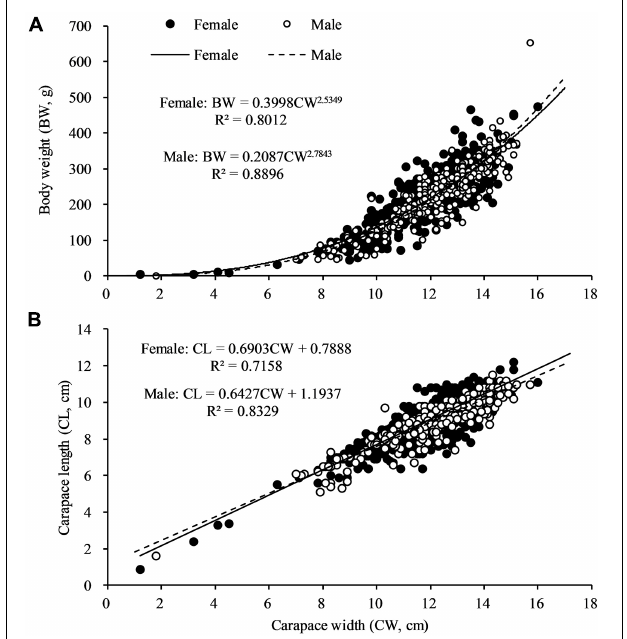
FIGURE 5 | (A) Body weight (BW) and carapace width (CW) relationship, and (B) carapace length (CL) and carapace width (CW) relationship for Calappa philargius males ( N = 408) and females ( N =